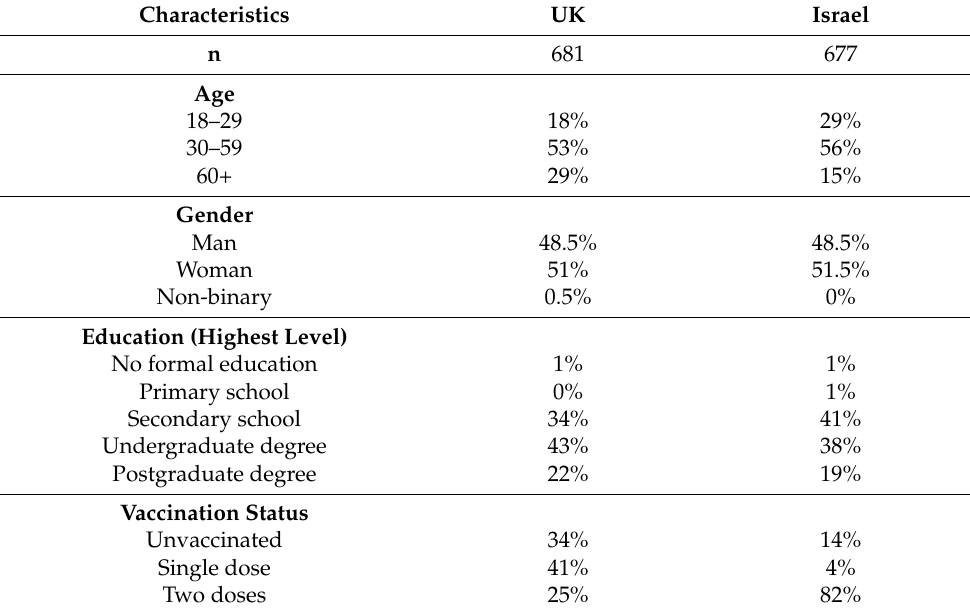
Table 3. Demographics and vaccine status of participants from the UK and